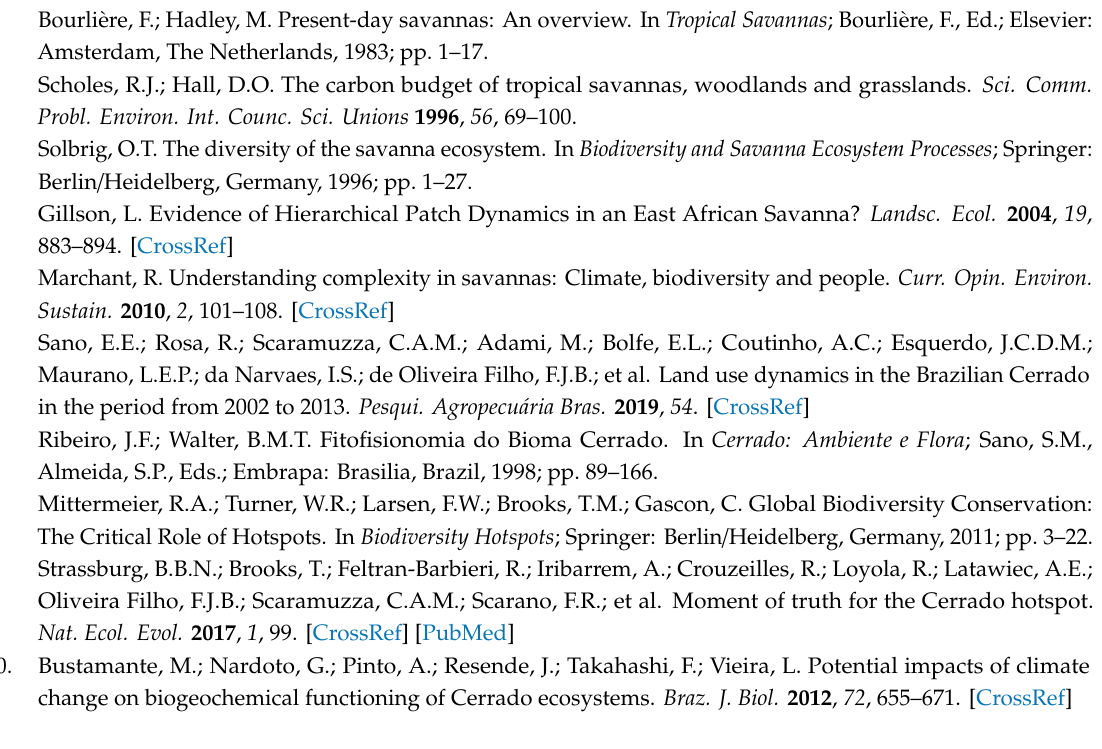
(empirical decision tree (EDT), initial statistical decision tree (SDT), and final SDT), considering the aggregated legend; Figure S5. State-level proportion of native vegetation (NV) in 2017, other non-NV land cover types in 2017, and NV net loss from 1985 to 2017. MS—Mato Grosso do Sul, GO—Goi á s, MT—Mato Grosso,